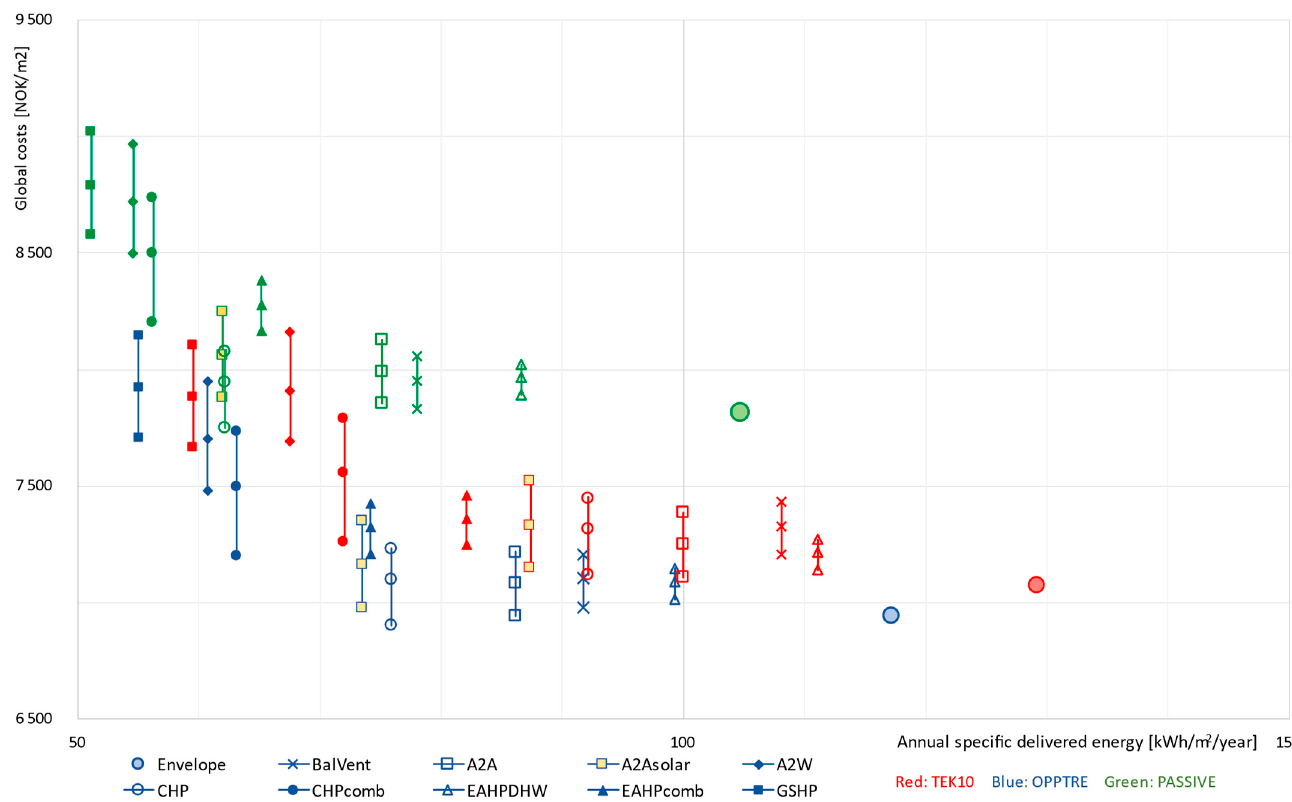
Figure 7. Specific global costs and delivered energy of the Kristiansand house. Minimum, average, and mean costs shown.